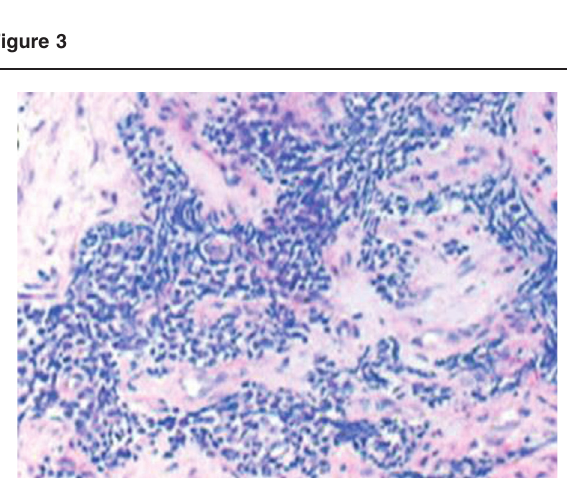
Chestradiographrevealing aleftupperlobemassandtwomasses on the right side without any lymphadenopathy.